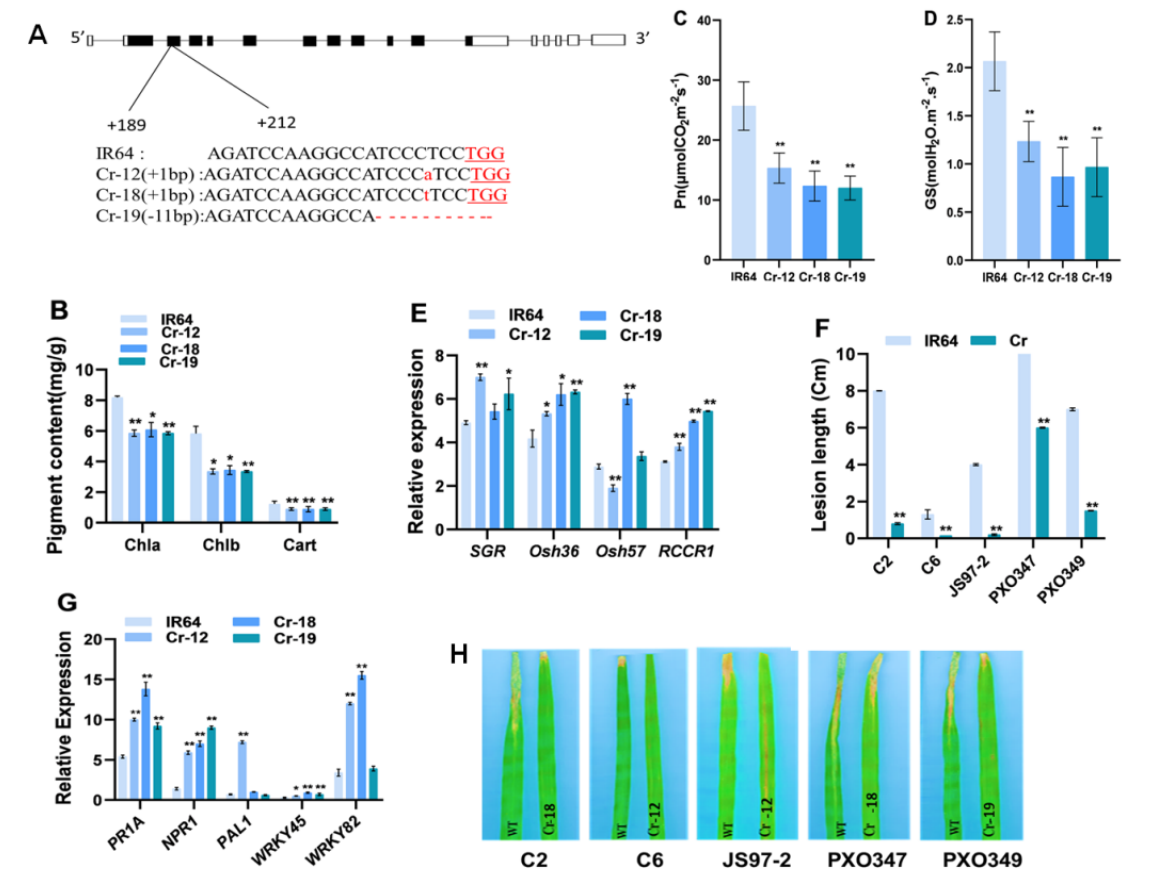
Figure 6. Analysis of OsHCAR knockout lines using CRISPR/Cas9. ( A ) CRISPR/CAS9 mediated mutation at target sites of OsHCAR in knockout lines. Cr–12, Cr–18 are homozygous mutants carrying 1 bp insertion whereas Cr-19 carries 11 bp deletion, the black letters represent the sgRNA target sequence and the underlined red letters represents PAM motif. ( B ) Chlorophyll content, ( C ) Net photosynthetic rate (Pn). ( D ) Stomatal conductance (Gs). ( E ) Relative expression of senescence genes. ( F ) Lesion length (cm). ( G ) Relative expression analysis of pathogenesis related genes in WT and knockout lines and ( H ) leaf phenotypes of WT and knockout lines after bacterial blight inoculation. Data are means ± SD of three biological replicates ( B – E , G ) and five biological replicates ( F ) (Student’s t -test: * p < 0.05; ** p < 0.01).